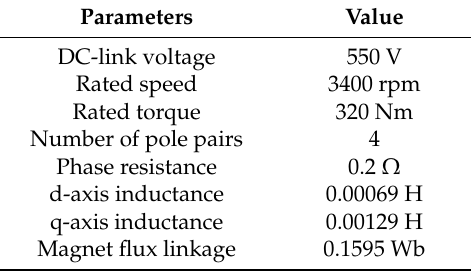
Table 1. Parameters of the interior permanent magnetic synchronous